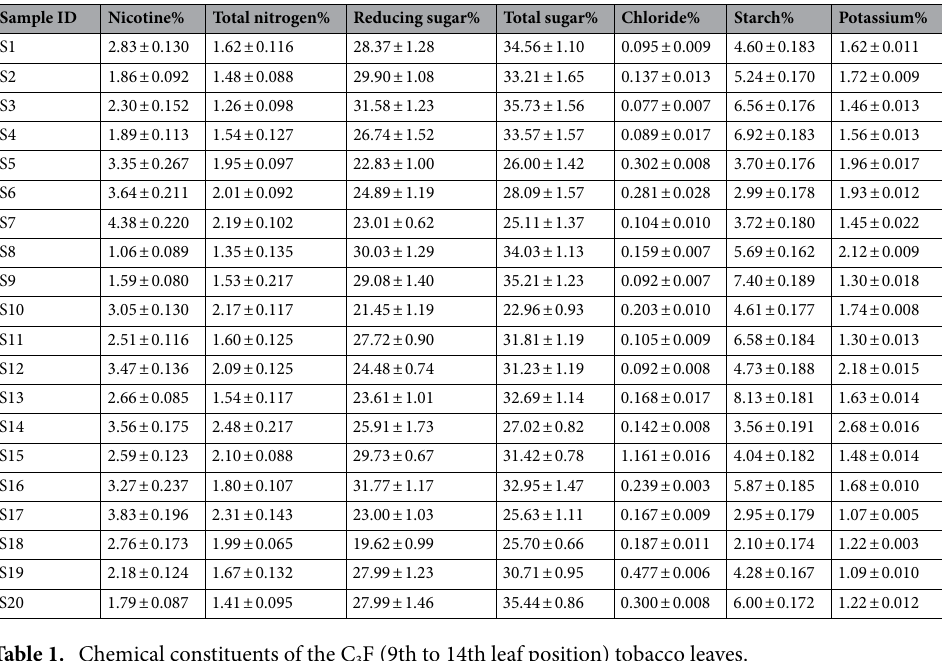
Table 1. Chemical constituents of the C 3 F (9th to 14th leaf position) tobacco leaves.